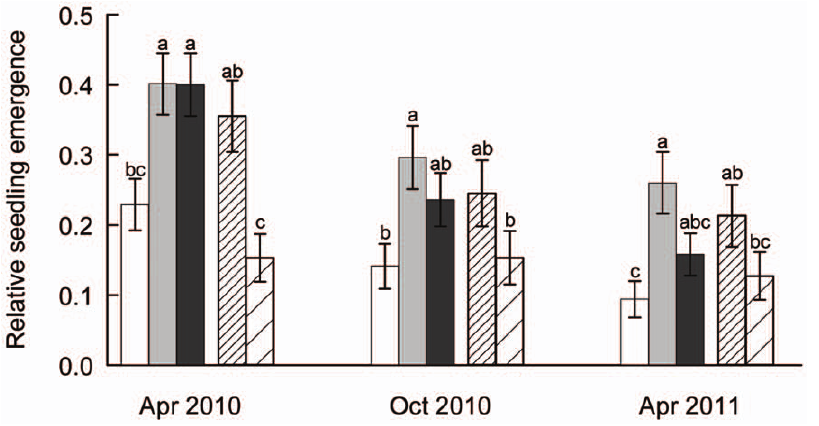
Figure 4. Average seedling emergence per species. Seed ling emergence (proportion of sown seeds) of the resident species Crepis capillaris (white), Hypochoeris radicata (gray), Leontodon autumnale (black) and the non-residents Picris hieracioides (densely hatched) and Senecio jacobaea (widely hatched) in spring 2010 (Apr 2010), after the first summer (Oct 2010) and one year after first emergence (Apr 2011). Data are means 6 s.e., n=48. Analysis of variance, calculated for each date separately, showed significant species effects (F 4,200 . 5, p , 0.0004). For each data, different letter denote means that are significantly different (at p , 0.05) according to Tukey test.